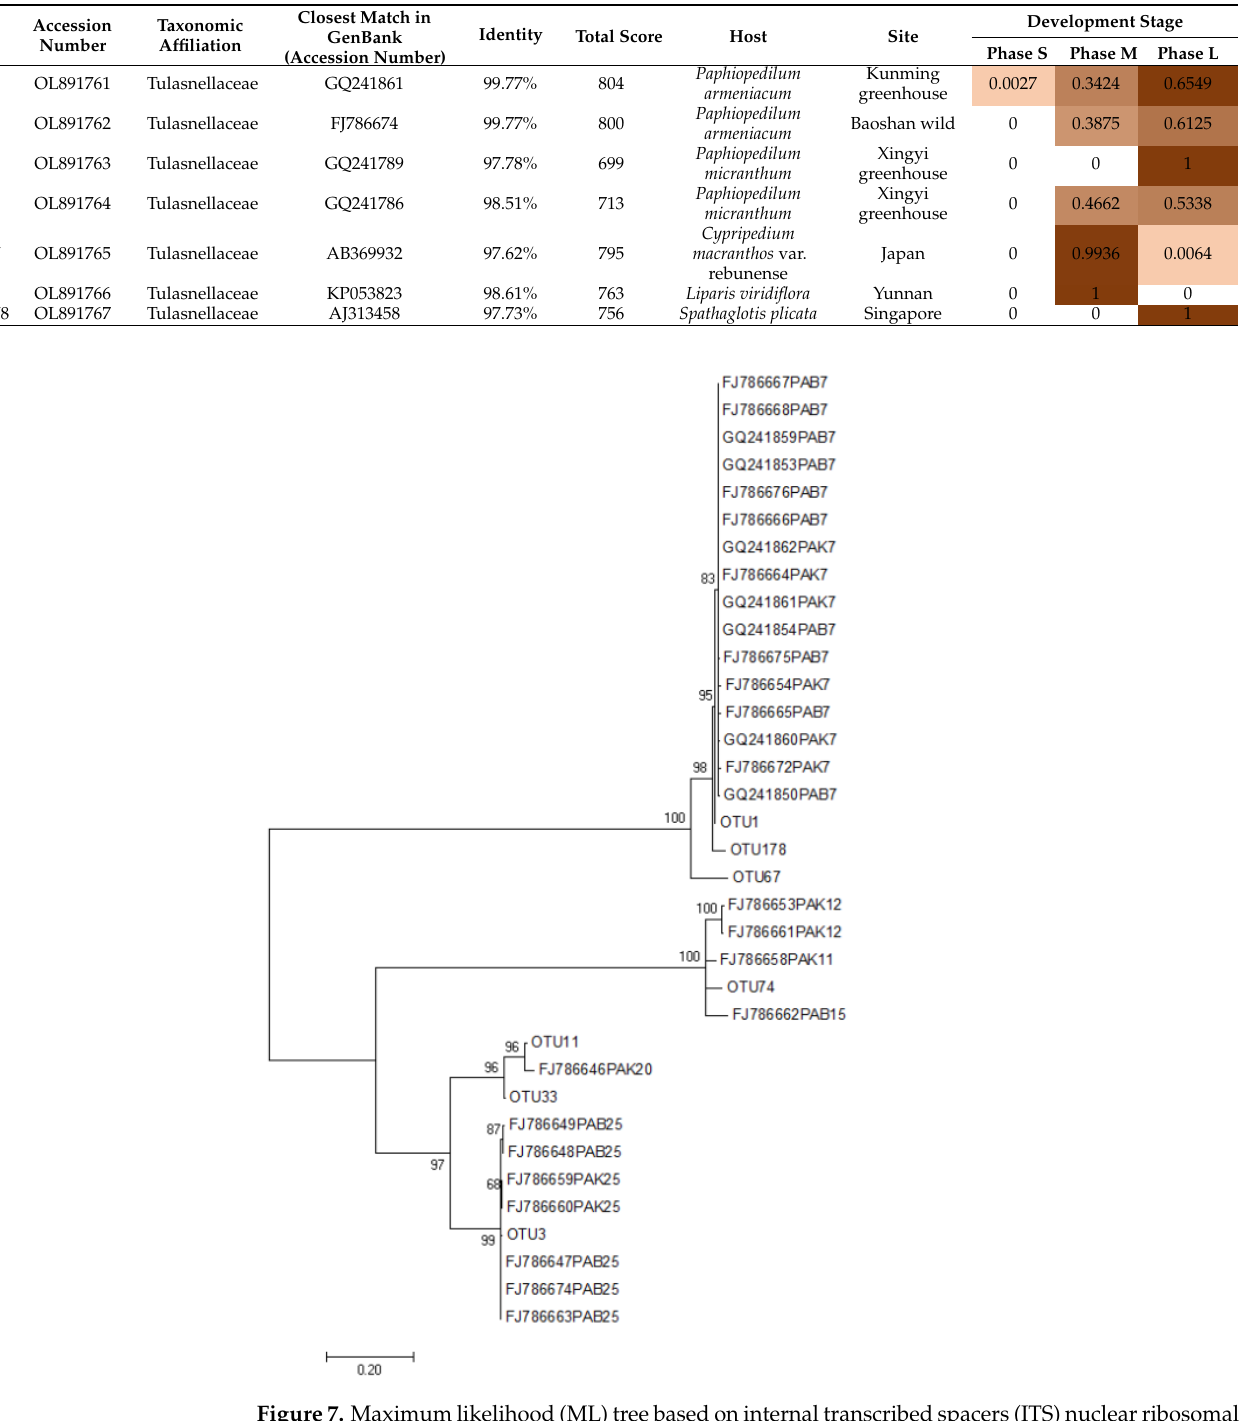
Table 1. List of mycorrhizal fungi operational taxonomic units (OTUs) in Paphiopedillum armeniacum , and relative abundance of each OTU at each development stage.